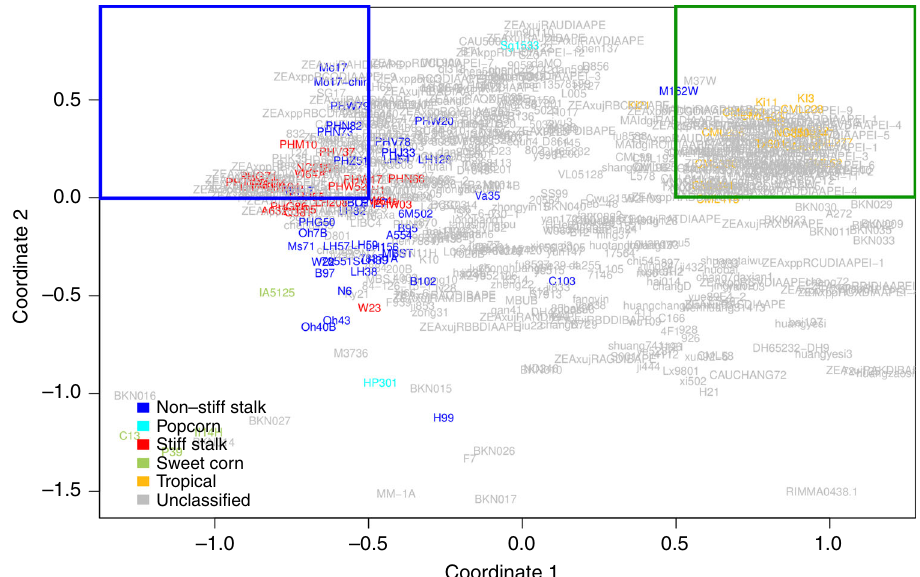
Fig. 2 MDS of genotypes used to selected 60 extreme individuals. Unique inbred individuals ( n = 916) from the HapMap 3.1 visualized by multi- dimensional scaling (MDS). The temperate materials are bound by the blue box (coordinate 1 < − 0.5, coordinate 2 > 0), and the tropical materials are bound by the green box (coordinate 1 > .5, coordinate 2 > 0). Two sets of 30 individuals were chosen from each box based on pedigree, genetic distance from others in the group (identity by state < 0.95), and quantity of missing SNP